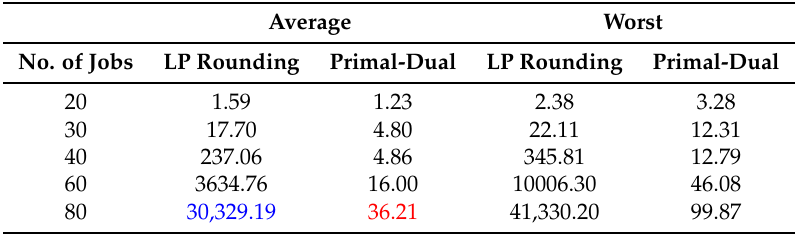
Table 3. The computation time in seconds for the TDHATSP.